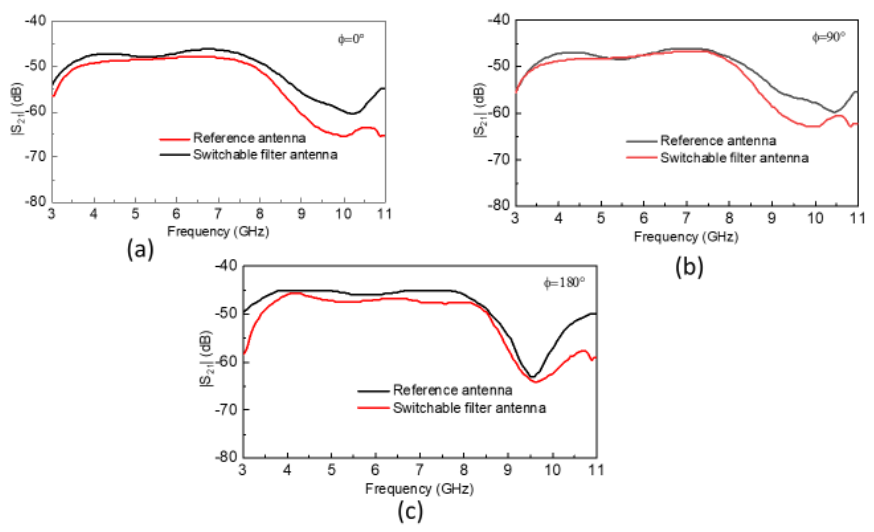
Figure 5. Measurement of S21 characteristics; ( a ) S21 magnitude at φ = 0°; ( b) S21 magnitude at φ = 90°; ( c ) S21 magnitude at φ = 180°.